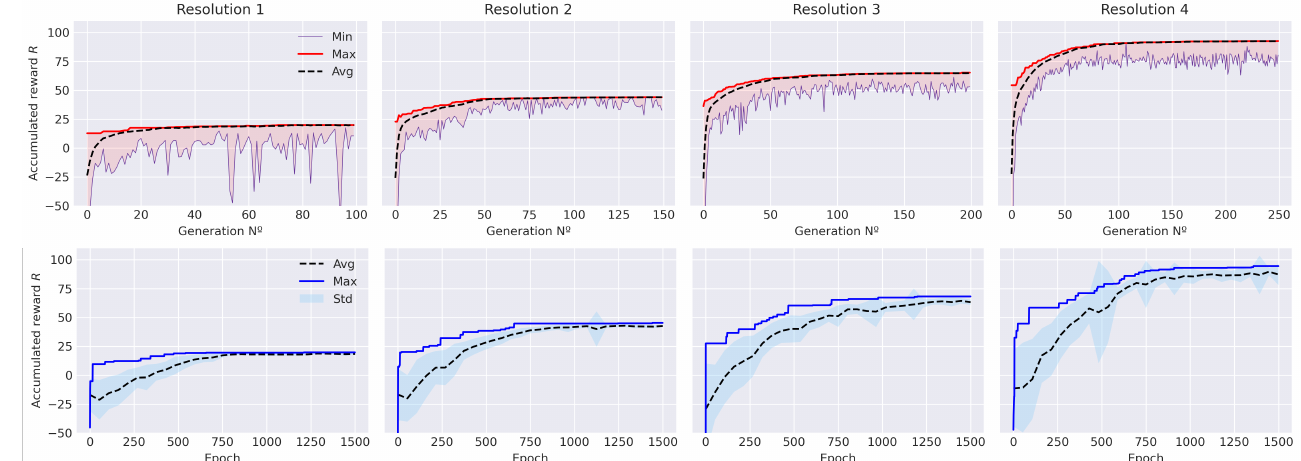
Figure 14. Accumulated reward along the training process in the EA approach ( up ) and in the DDQL approach ( down ). Note in the EA, every data corresponds to a generation whereas in the DDQL corresponds to an episode.